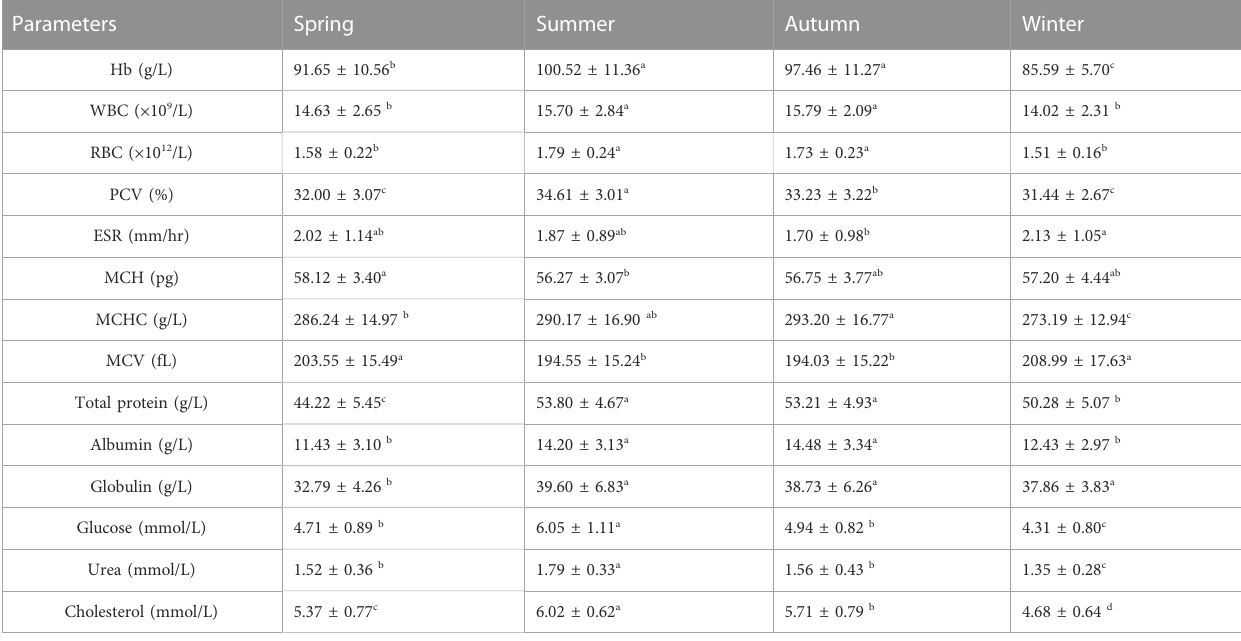
TABLE 6 Seasonal variations in hematological and serum biochemical parameters of female S. esocinus from River Jhelum a .